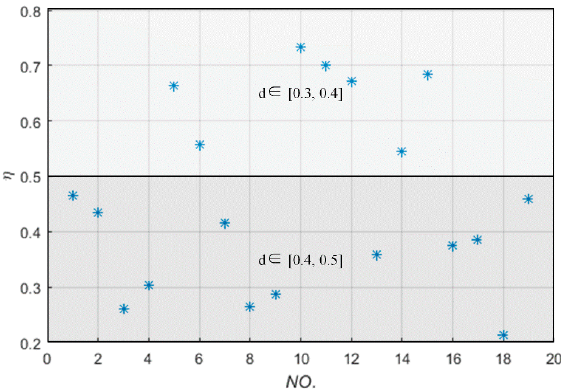
Figure 18. The power transfer efficiencies versus the receiving coil moving and rotating in the spherical shell.